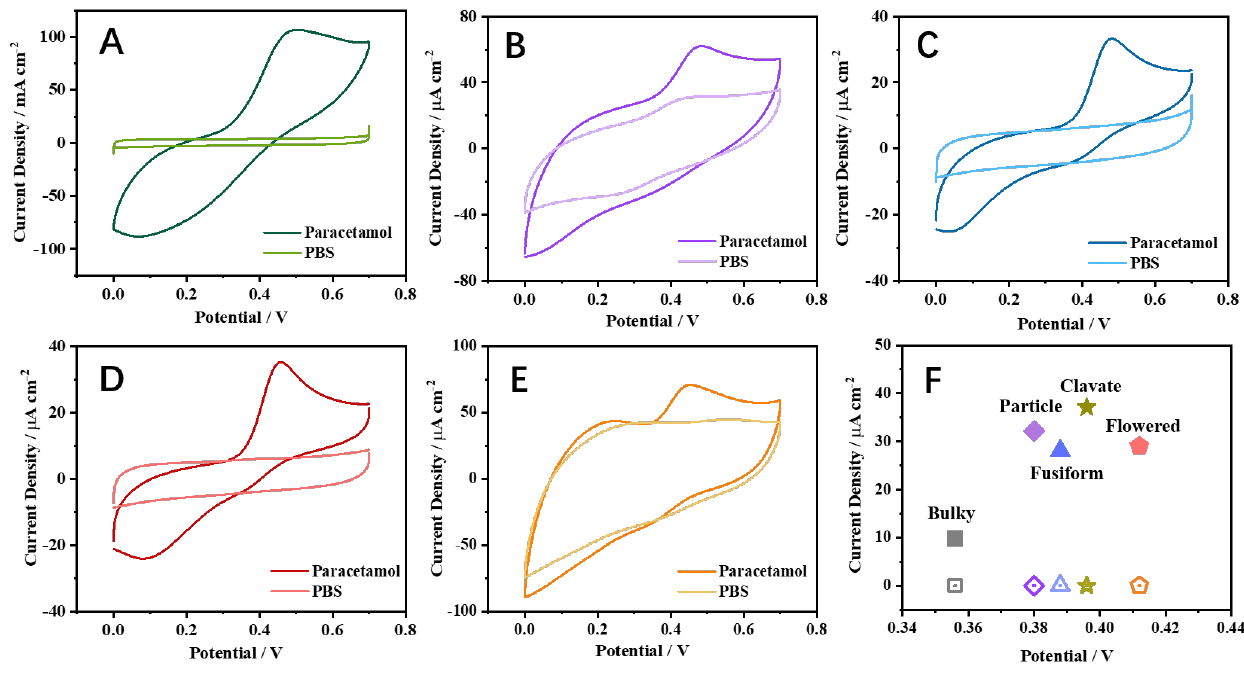
Figure 3. CV curves at ( A ) clavate, ( B ) fusiform, ( C ) flowered, ( D ) bulky, and ( E ) particle BiVO 4 in 0.01 M PBS with and without 100 µM paracetamol. Scan rate: 100 mV s −1 . ( F ) The current densities at BiVO 4 electrode in 0.01 M PBS without (hollow icon) and with (solid icon) 100 µM paracetamol from the DPV curve. The X − axis is the peak potential at different morphologies of BiVO 4 from DPV curves.